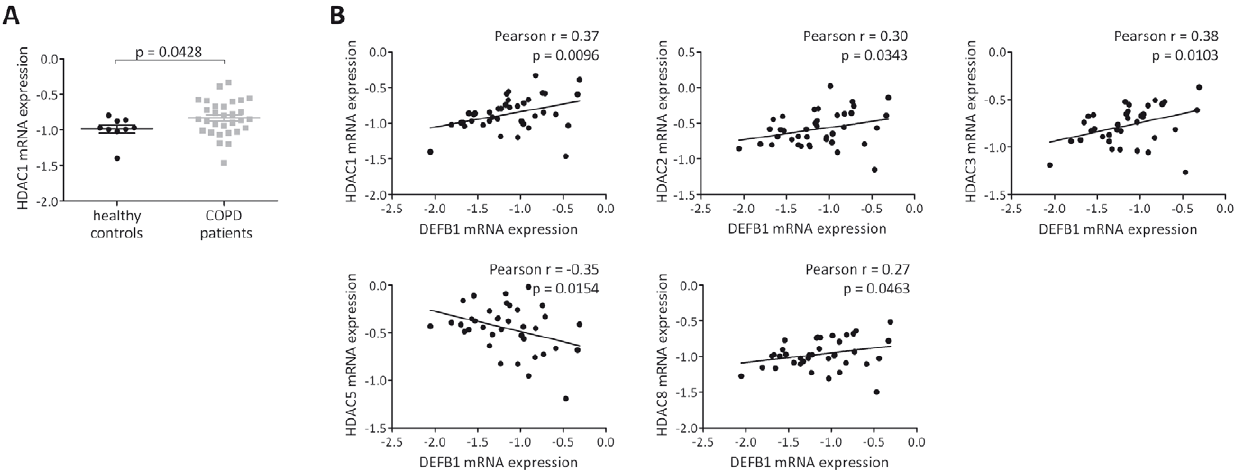
Figure 2. HDAC mRNA expression analysis in bronchial epithelial cell biopsies from patients with COPD and healthy controls. ( A ) Expression levels of HDAC1 mRNA in epithelial cell biopsies from patients with COPD (N=34) and healthy controls (N=10). Levels of HDAC1 mRNA were quantified by Real-time PCR, variations of transcript levels were corrected by b 2-M mRNA levels and log transformed for statistical analysis. Analysis of variance between patients with COPD and healthy controls was performed by the use of the unpaired t-test with differences p , 0.05 considered significant. Results are presented as mean 6 SEM, each symbol represents a single sample. ( B ) Correlations between levels of HDAC1 mRNA and HDAC1-3, 5 and 8 mRNA in epithelial cell biopsies from patients with COPD (N=34) and healthy controls (N=10). Analysis was performed using Pearson correlations with differences p , 0.05 considered significant. Each symbol represents a single sample. (The complete data and p values are given in supporting information, Figures S2 and